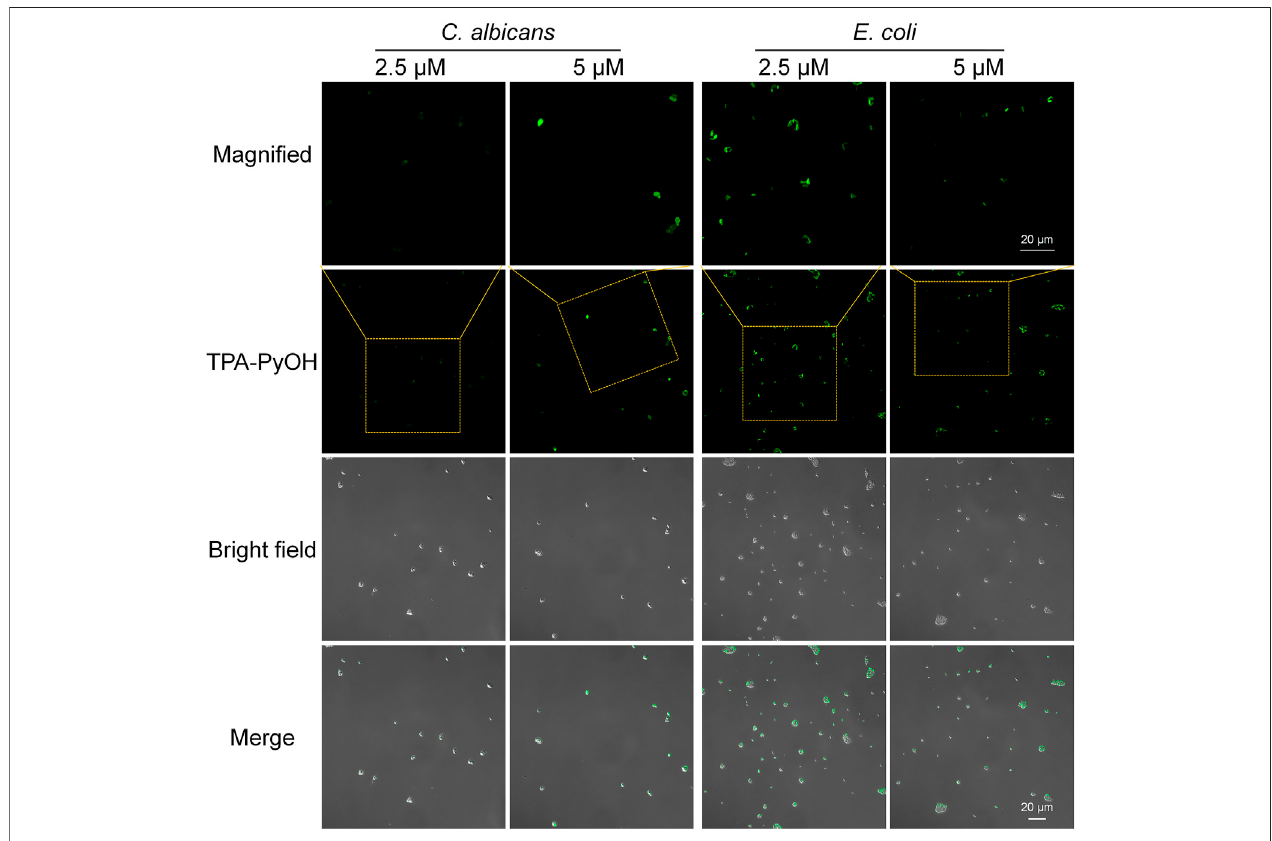
FIGURE 4 | CLSM images (40 × ) of E. coli and C. albicans after staining with TPA-PyOHfor 5 min. TPA-PyOH wasexcited at 488 nm, and the emission range was collected at 520 – 670 nm. Green pseudo color is used to represent fl uorescent signal from TPA-PyOH channel.